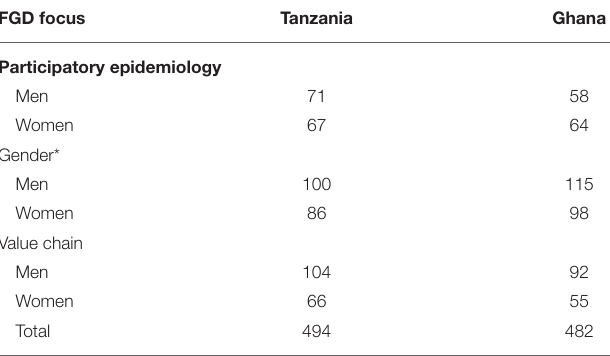
TABLE 2 | Breakdown of focus group participation by gender. FGD